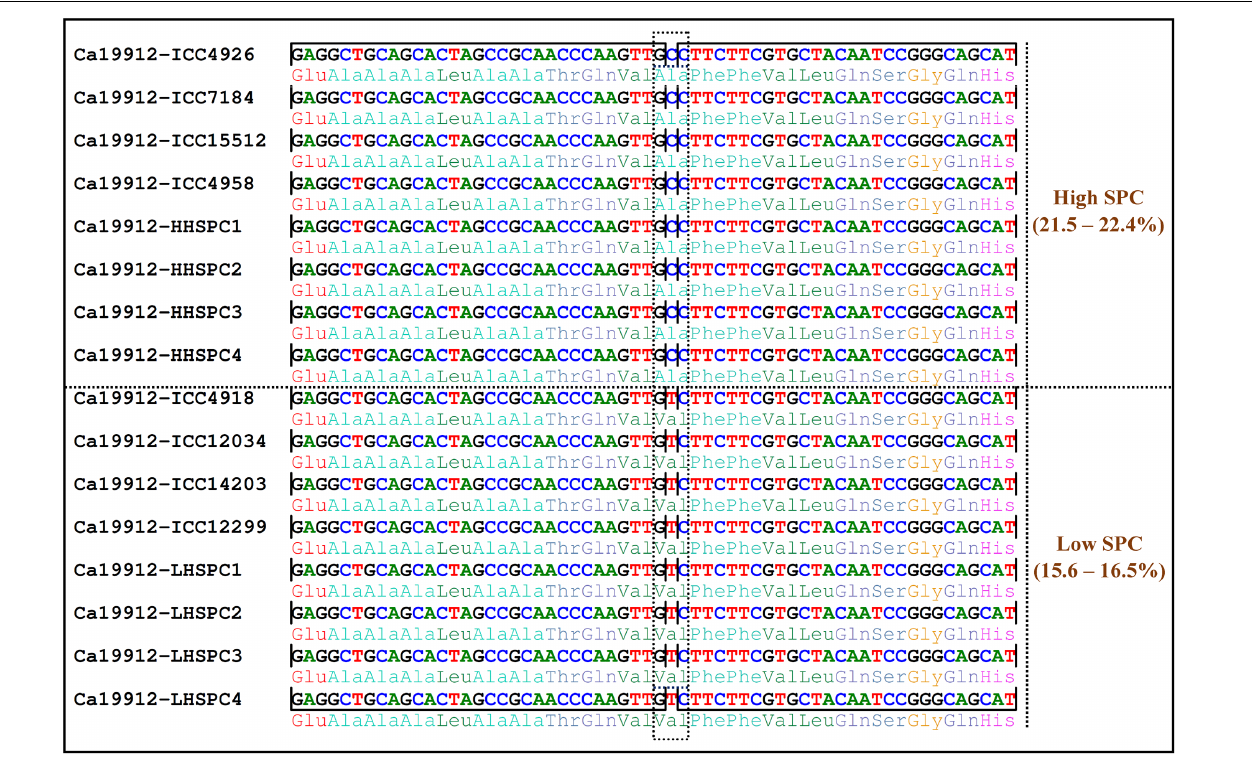
FIGURE 4 | SNP (C to T) exhibiting missense non-synonymous amino acid substitution [alanine (GCC) to valine (GTC)] in a zinc finger transcription factor gene (Ca19912) of kabuli differentiated the high from low SPC-containing accessions, parents, and homozygous RIL individuals of an intra-specific mapping population (ICC 12299 × ICC 4958). The sequence region containing the non-synonymous SNP is highlighted with a dotted box.